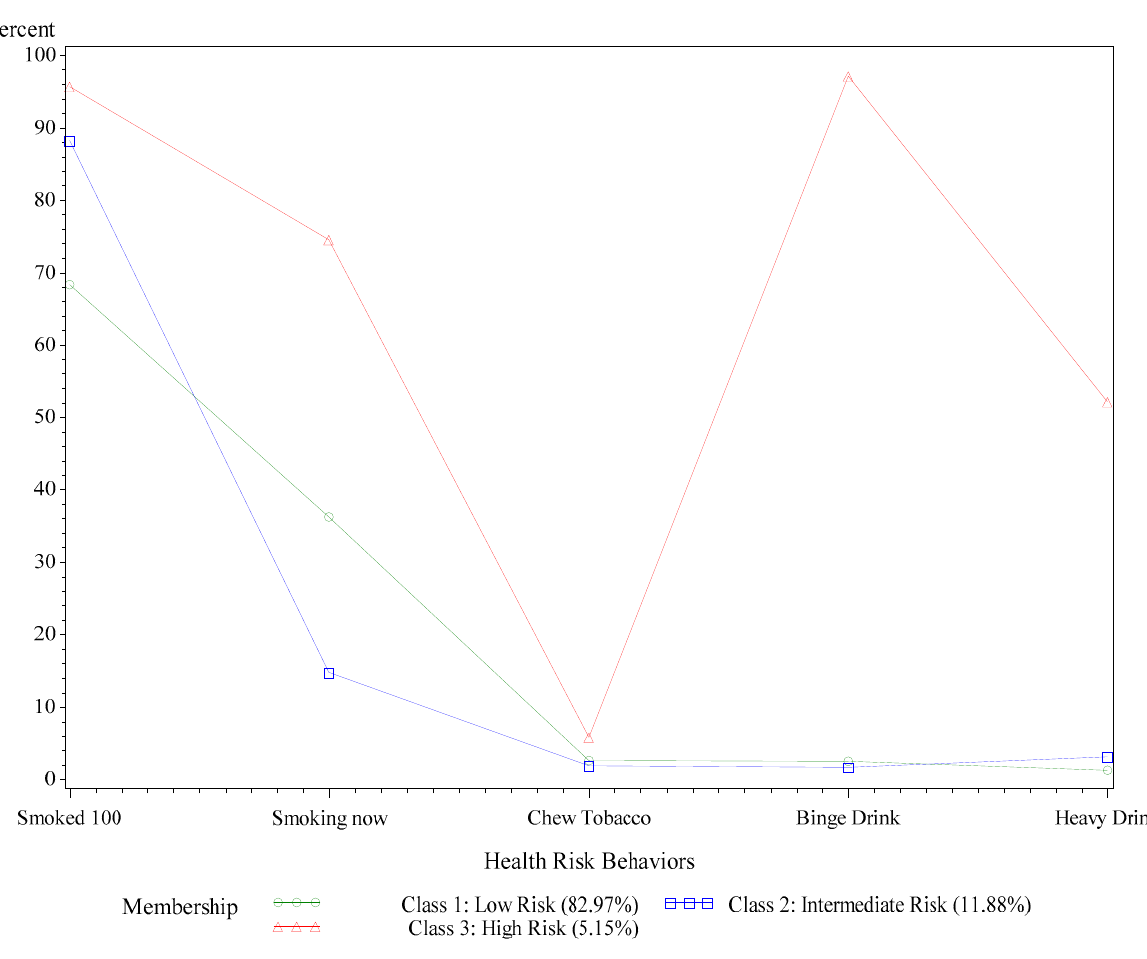
Figure 3. Prevalence probabilities of substance use and abuse behaviors by latent class, AL adults with COPD, BRFSS, 2015–2019. Binge drinking is defined as ≥ five drinks for men or ≥ four drinks for women on one occasion during the past 30 days. Heavy drinking is defined as men having >14 drinks per week and women having >7 drinks per week. Behaviors refer to the past 30 days.